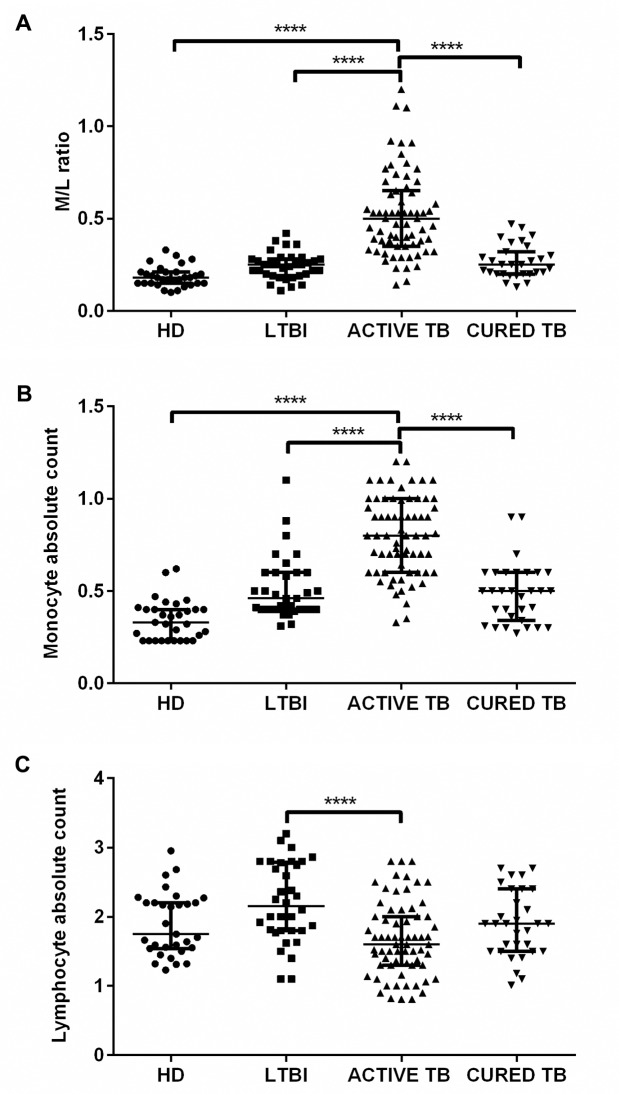
Ratio of monocytes to lymphocytes (ML ratio) of patients with active TB disease, LTBI subjects, cured TB patients and HD.A. Each dot represented ML ratio of a studied individuals. A horizontal bar indicates the median of each group. Significance of differences between groups was compared using Kruskal-Wallis test. *p<0.00001. B. Monocyte absolute count of active TB patients at diagnosis, LTBI subjects, cured TB patients and HD. Each dot representes the value of an individual subject. Each horizontal bar represents the median of each group. p<0.00001 were considered statistically significant. C. Lymphocyte absolute count of active TB patients at diagnosis, LTBI subjects, cured TB patients and HD. Each dot represents the value of an individual subject. Each horizontal bar represents the median of each group. p<0.00001 were considered statistically significant.